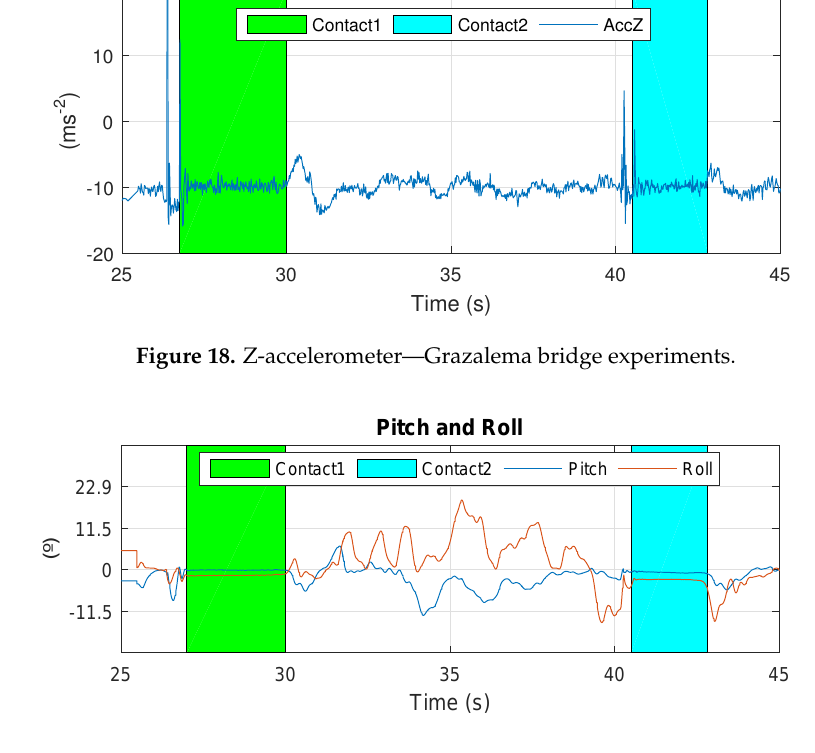
Figure 19. Pitch and roll—Grazalema bridge